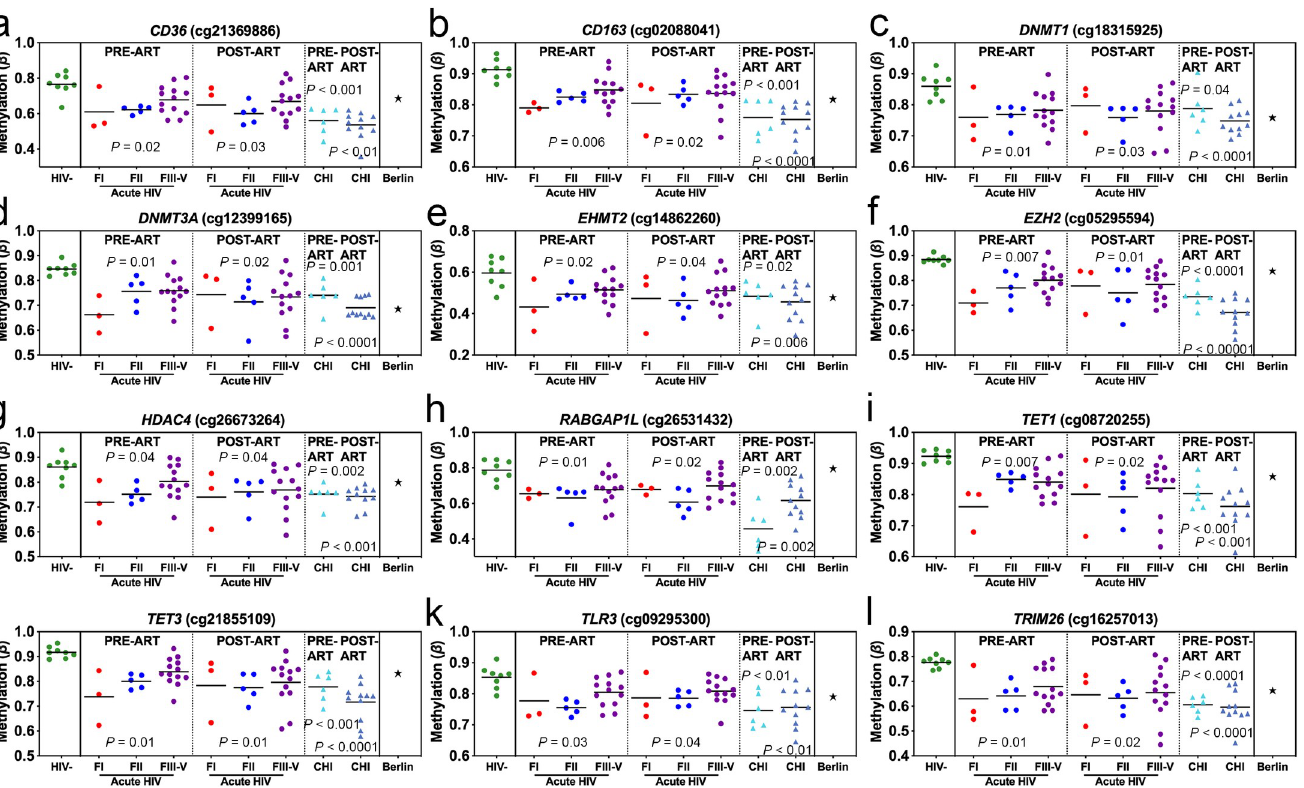
Fig 5. Differentially methylated loci identified in monocyte cells that persist in acute and chronic HIV infection despite ART. (a-l) Plots of durable differentially methylated loci in in AHI Fiebig I (red), Fiebig II (blue) Fiebig III-V (purple) at Pre-ART and Post-ART time points compared to HIV- (green) at single CpGs sites related to specific genes or intergenic regions of the genome displayed in bold italic above CpG ID (cg#). Validation of these same durable differentially methylated loci in monocytes displayed for chronic HIV infection at Pre-ART (aqua) and Post-ART (light blue) along with the Berlin patient (star). Significance determined comparing HIV- vs. AHI pre-ART, AHI post-ART, CHI pre-ART, and CHI post-ART and using FDR adjusted P-values < 0.05.